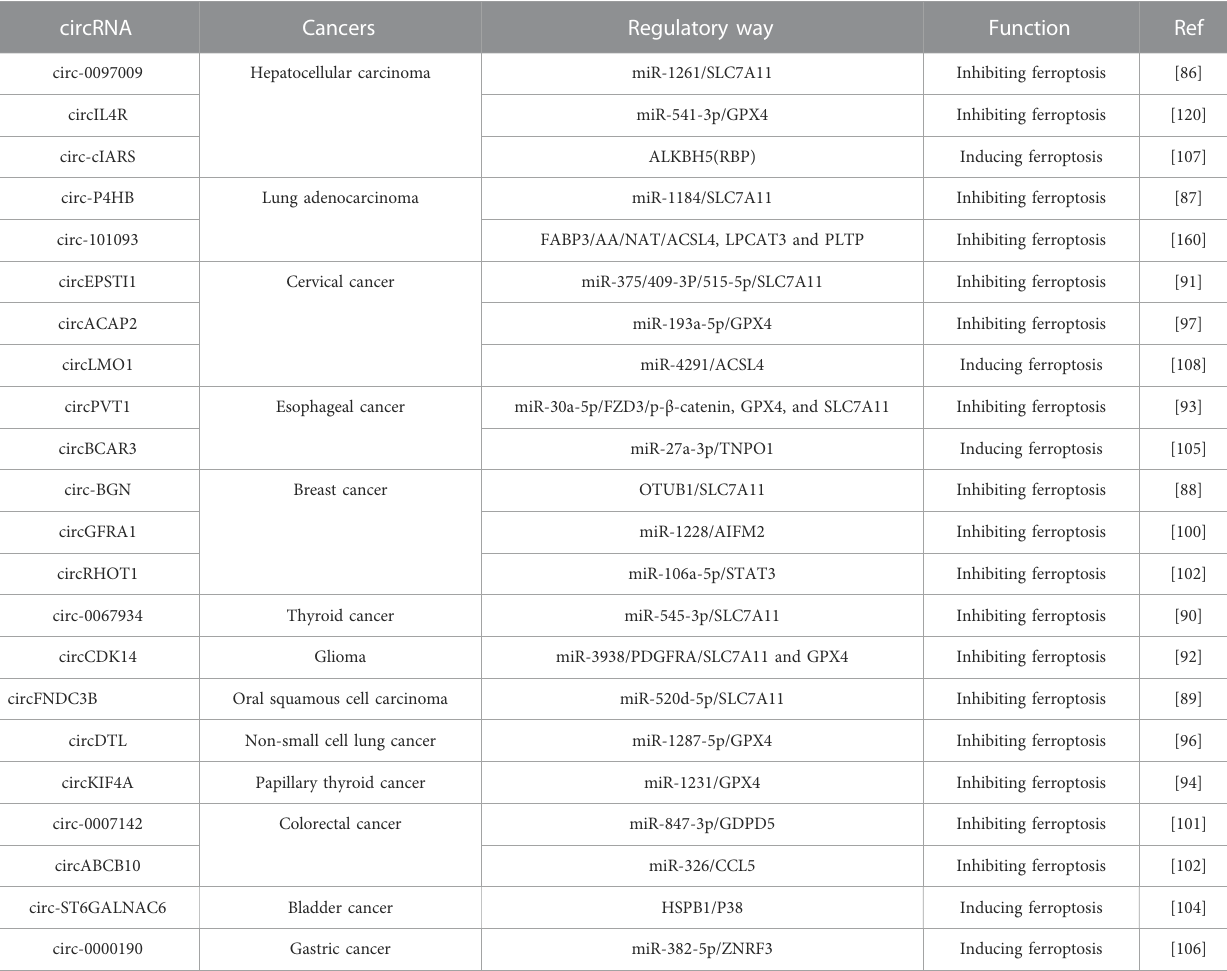
TABLE 1 Role of ferroptosis-related circRNA in